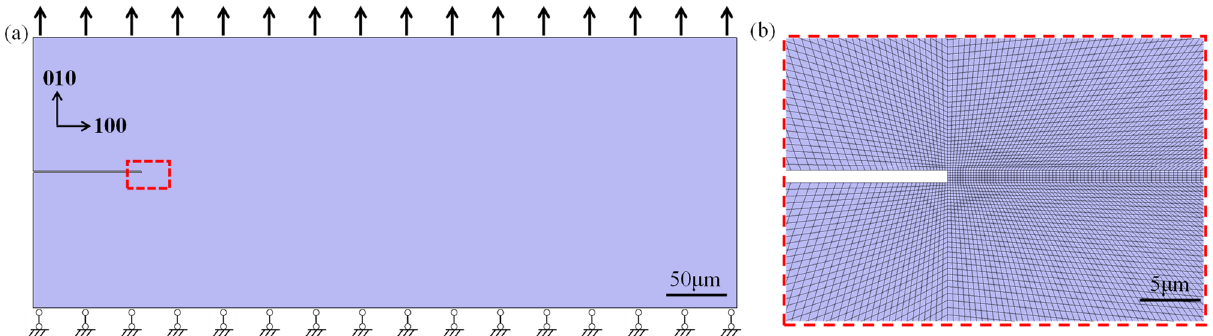
Figure 3. The notched single crystal tungsten sample. ( a ) The boundary conditions. ( b ) Enlargement of the mesh around the crack tip zone marked by the red dotted box in ( a ).